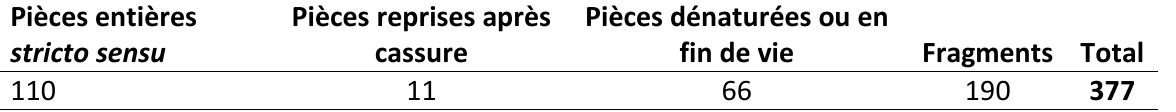
Tableau 1. Degrés d’intégrité des pièces façonnées unifacialement de GO-JA-01. Table 1. Integrity level of the unifacially shaped artefacts from GO-JA-01